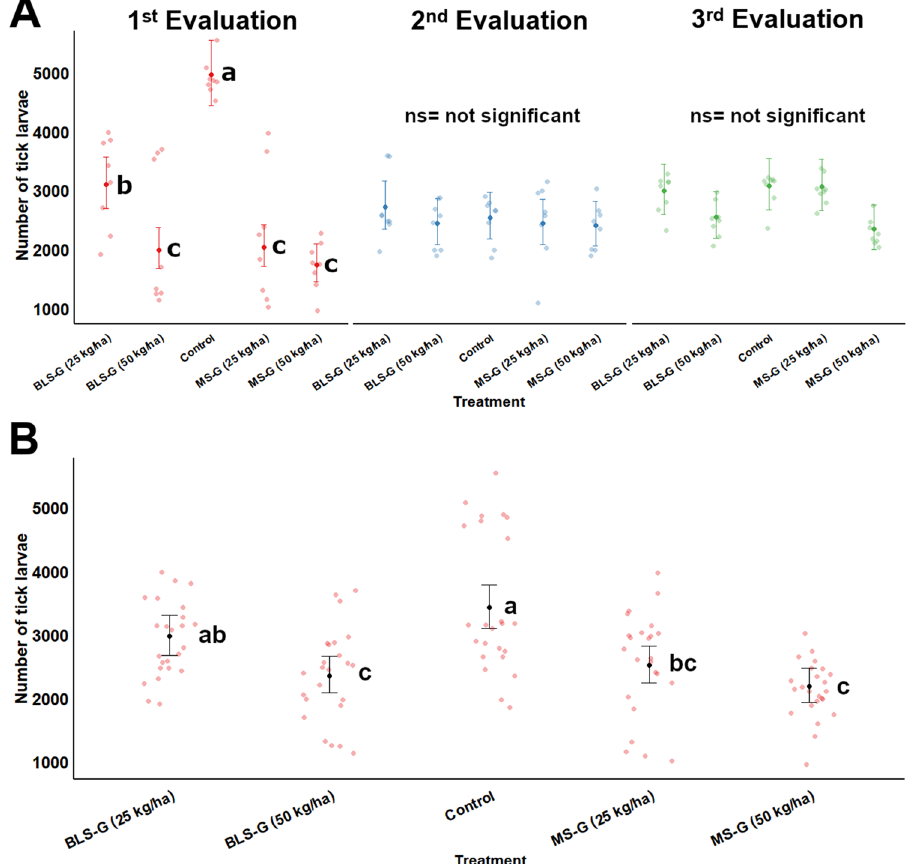
Figure 1. Impact of granular formulations at different rates of Metarhizium robertsii microsclerotia and blastospores on the density of tick larvae on grass pots. Number of Rhipicephalus microplus larvae counted on grass-pots after soil amendments with 50 or 25 kg/ha of microsclerotia-based granules (MS-G) or blastospores- based granules (BLS-G). ( A ) The average number of larvae compared between treatments in three evaluations periods when R. microplus female ticks were exposed to the treated environment. In the first and second evaluation, the immediate and residual effect of the first fungal soil application was assessed respectively, in the third evaluation the effect of a new application of the formulations was verified. ( B ) Overall effect obtained in the number of tick larvae on the three populations of ticks throughout the test period considering the two fungal treatments. Means (n = 8) are dots and whiskers represent 95% confidence intervals. Means followed by distinct letters indicate significant differences (Tukey HSD test P < 0.05). Raw data are shaded